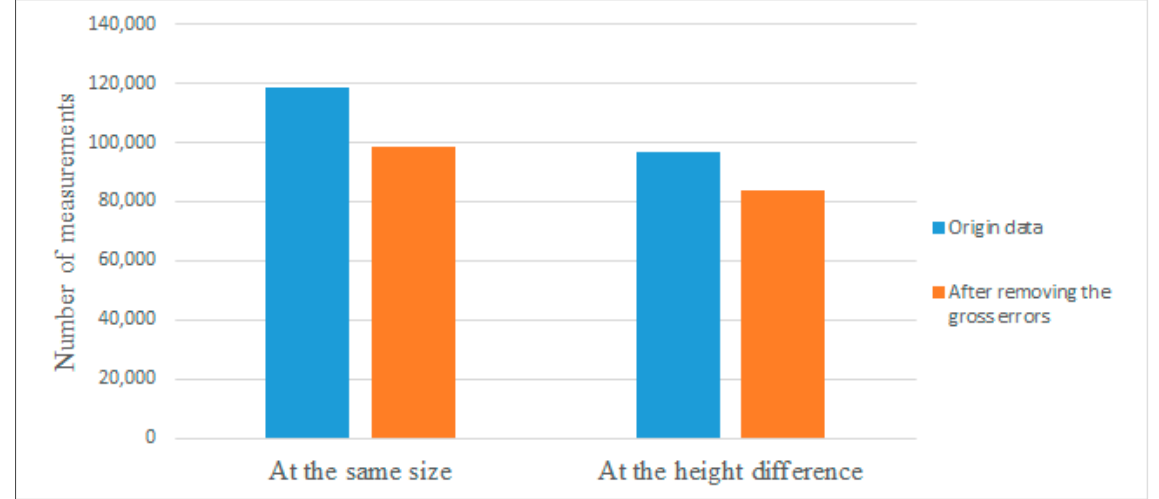
Figure 5. Correlation histogram of the original data and the data obtained after removing the gross errors.